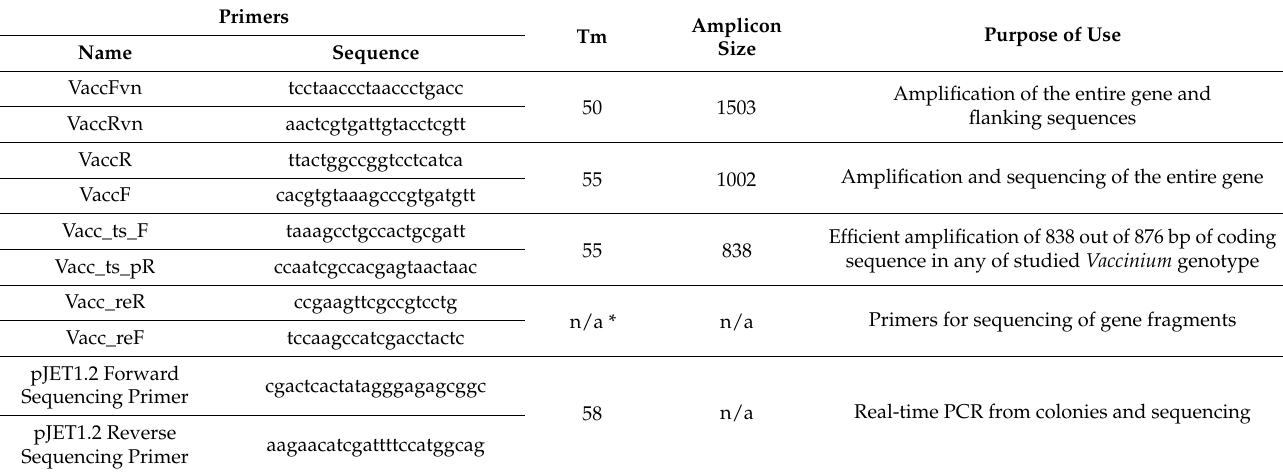
Table 3. Primers used in the